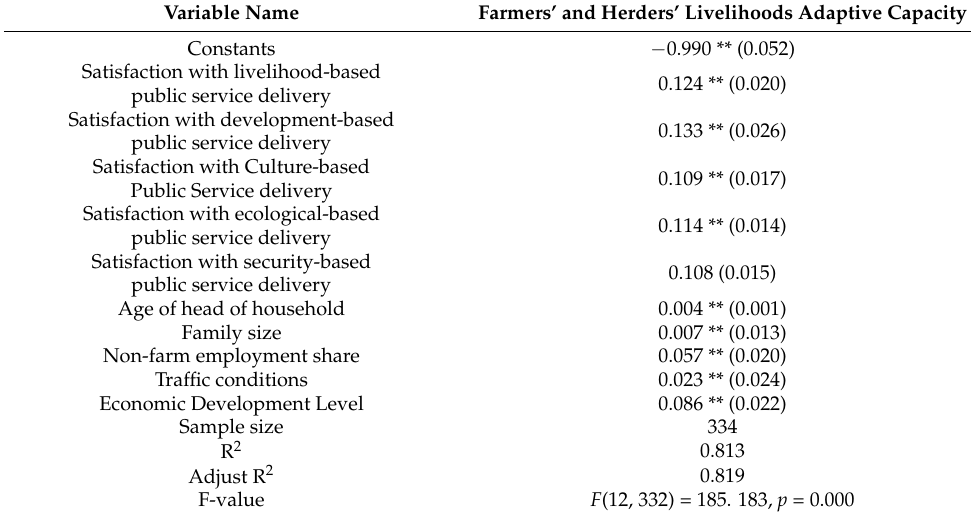
Table 5. Overall effect of public service delivery on the livelihood adaptive capacity of farmers and